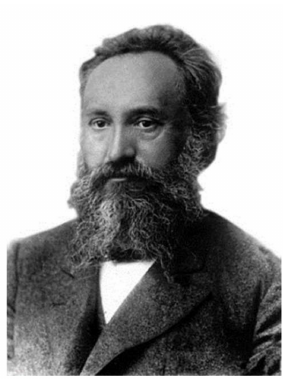
Figure1. EvgrafStepanoviˇcFedorov(https: // de.wikipedia.org / wiki /